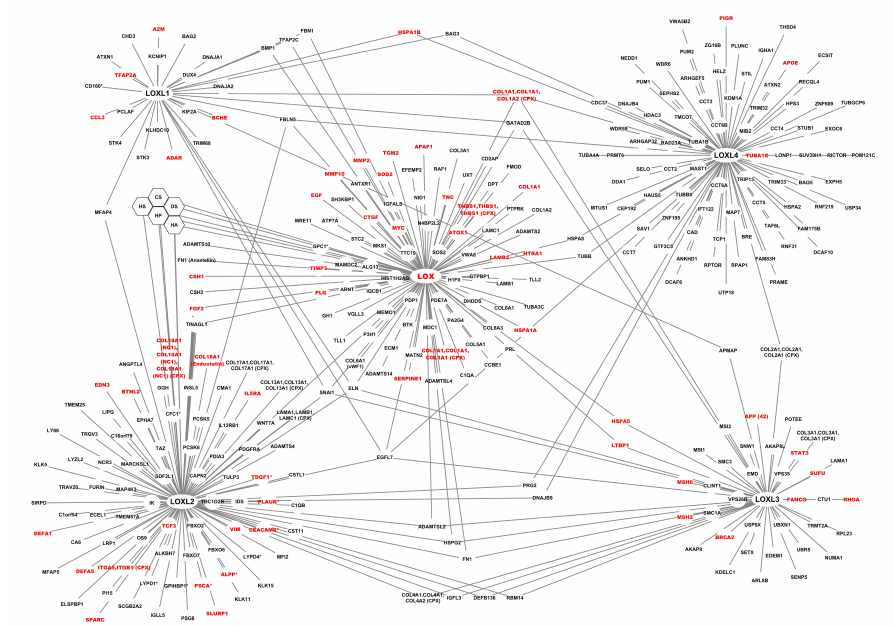
Figure 8. Interactome of the five members of the LOX family. Black: protein partners of LOX and LOXLs, Red: protein partners of LOX and LOXLs (including LOX) annotated as “Cancer-related condition” in Reactome FIViz as described in the material and methods section. Hexagons: glycosaminoglycans, *: glycosyl-phosphatidylinositol-anchored